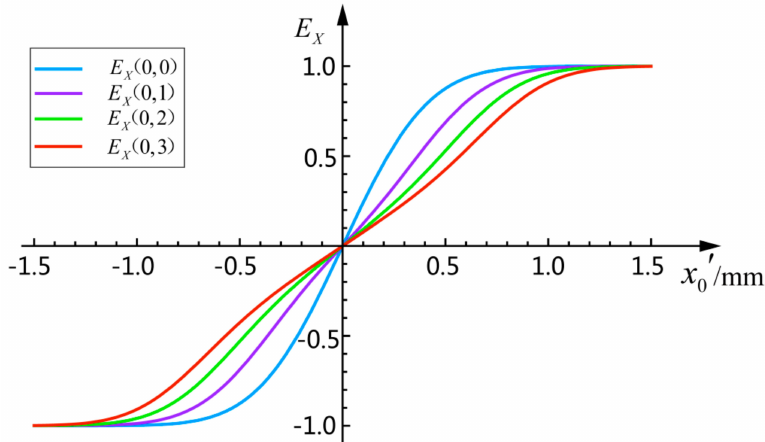
Figure 3. Relationship of x 0 (cid:48) , E X ( 0,0 ) , E X ( 0,1 ) , E X ( 0,2 ) , and E X ( 0,3 )